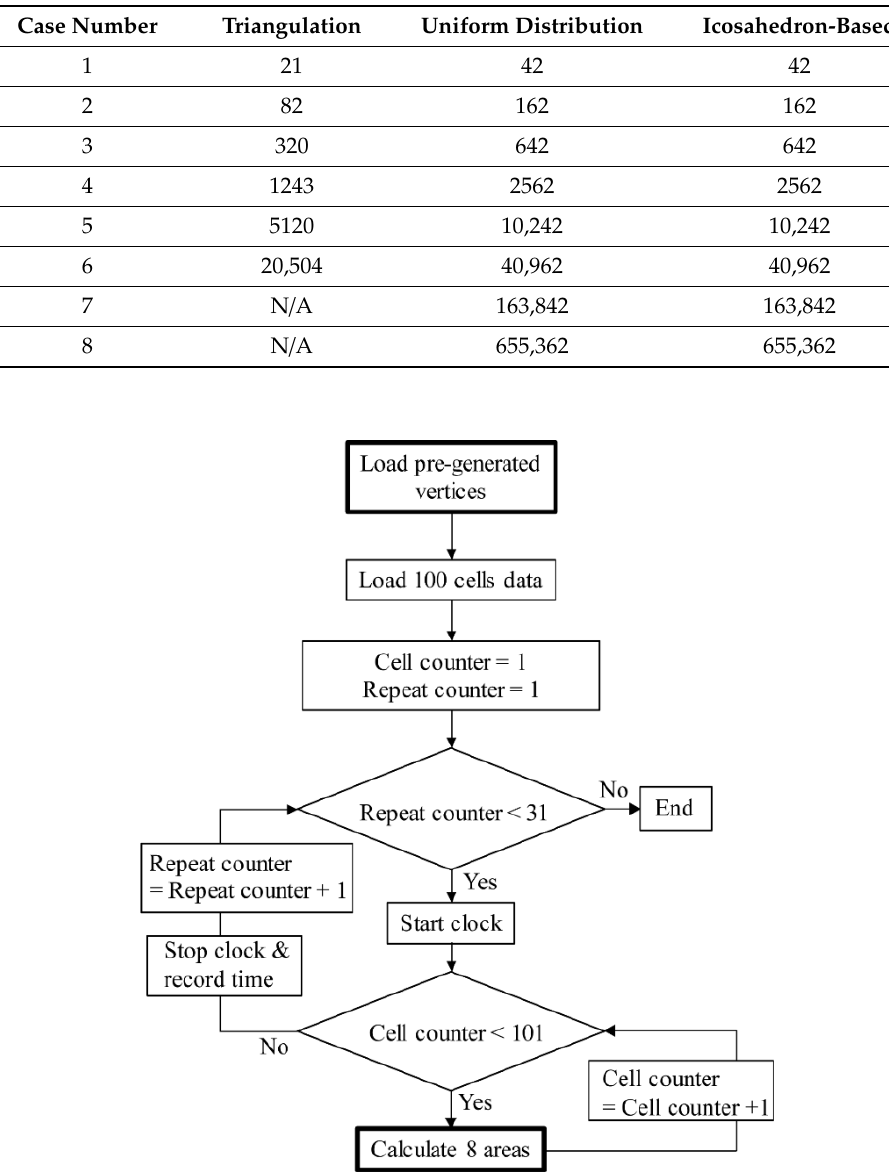
Figure 6. Flow chart for computations in three methods. This flow chart describes the basic structure of the computations performed by three methods. There are two parts that are method specific. They are indicated with thickened boxes. A set of pre-generated 100 cells is commonly used. Each method computed eight areas of every cell—a total of 800 area calculations. These calculations are repeated 30 times to measure the average computation time.